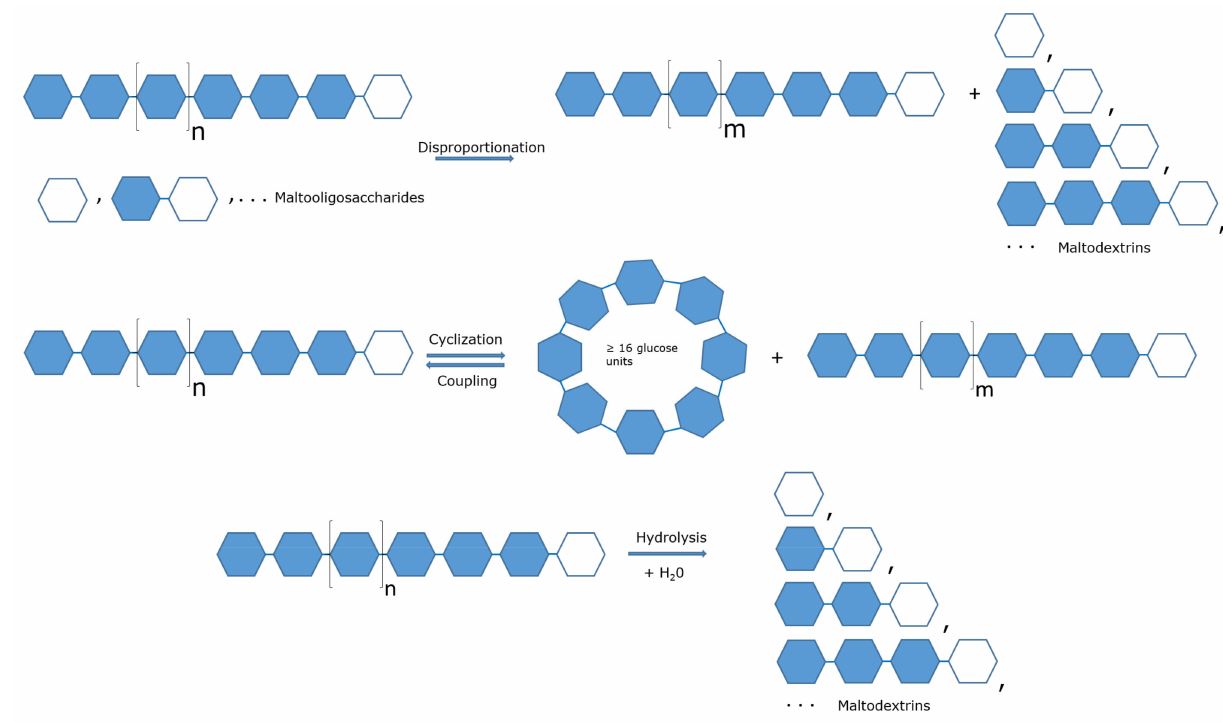
Figure 1. Typical reactions catalyzed by 4 α -GTases. Disproportionation: the enzyme catalyzes the hydrolysis of a glucosidic bond in the donor α -1,4 (cid:48) - D -glucan and the transfer of the glucoside with the newly formed reducing end to the 4 (cid:48) position of an acceptor glucose, maltooligosaccharide or glucan. The length of the acceptor molecule can influence the kinetic parameters of the reaction (see main text). Cyclization: an intramolecular reaction in which the glucoside produced in the hydrolytic step makes an internal glucosidic bond between its reducing end and its free 4 (cid:48) -position. Coupling: a cycloamylose molecule is firstly linearized in the course of the hydrolytic step and then transferred to an acceptor α - 1,4 (cid:48) - D -glucan. Hydrolysis: only the hydrolysis of a glucosidic bond occurs without any further binding step. Coloured hexagons represent glucose units in glucan molecules (amylose, oligosaccharides and cycloamylose); open hexagons stand for glucan-reducing ends. In the coupling reaction, any linear glucoside can serve as acceptor. Figure modified from